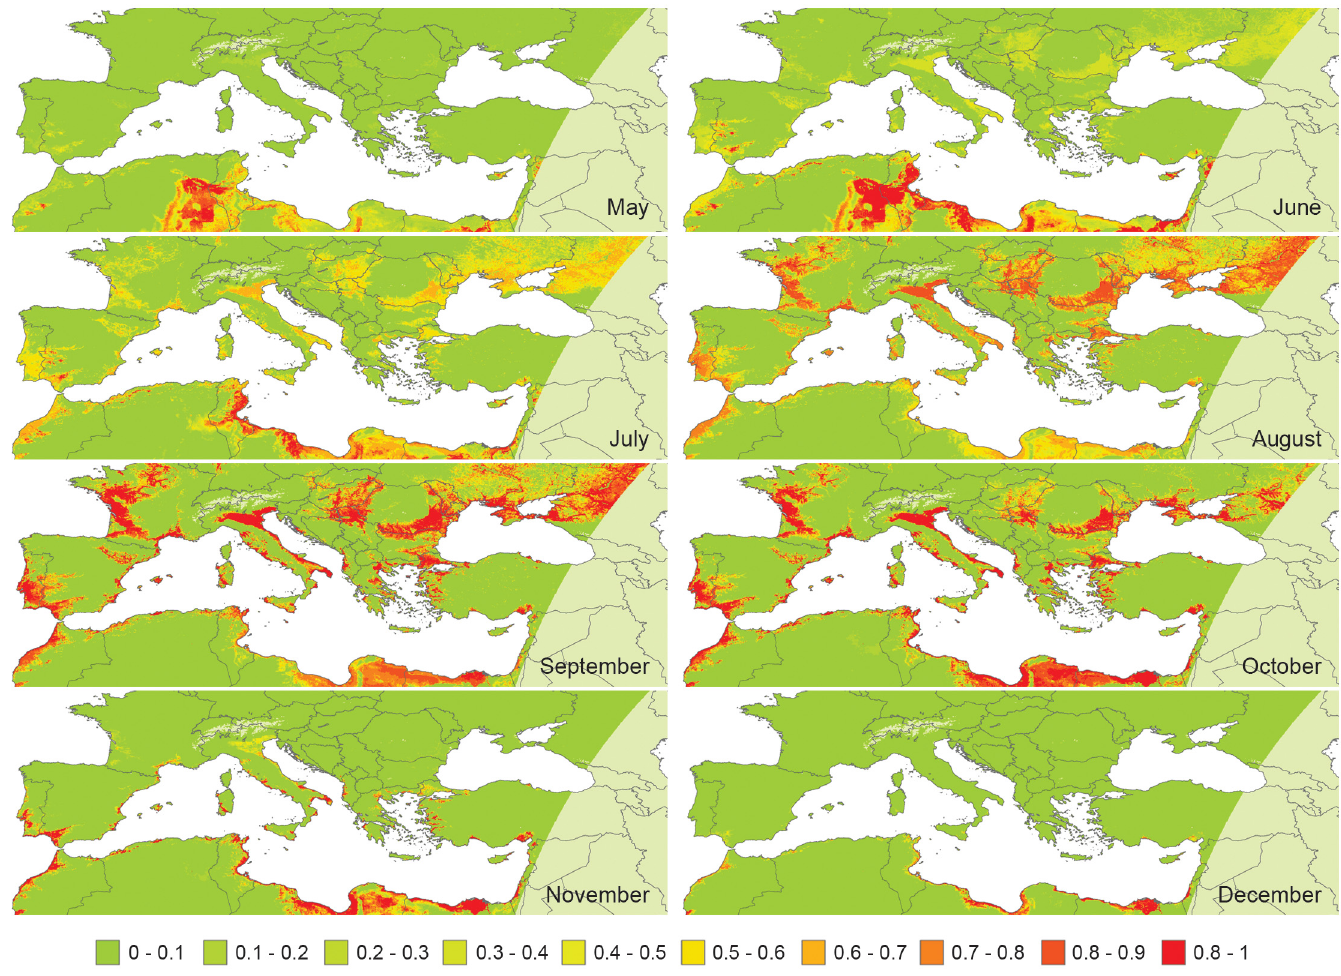
Fig 2. West Nile Disease suitability maps (on a monthly basis) from May to December for the study area. From January to April, no areas suitable for WND were predicted (probability was less than 1%).